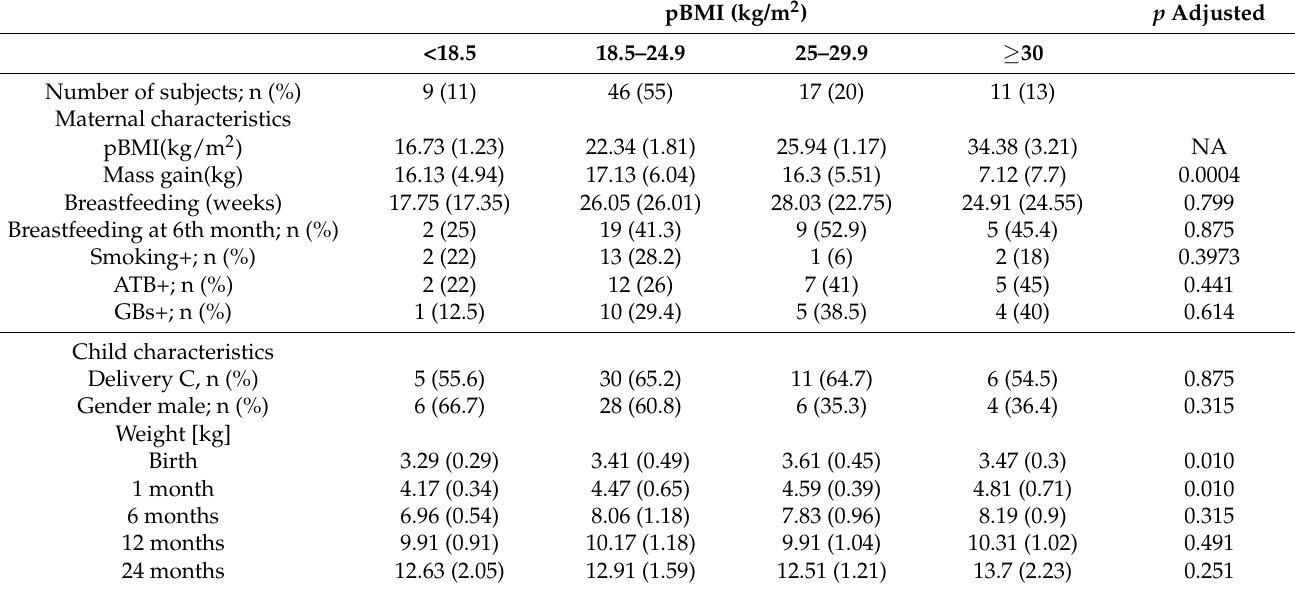
Table 2. The characteristics of study participants among 83 mother-infant pairs according to pBMI weight categories in Szczecin,